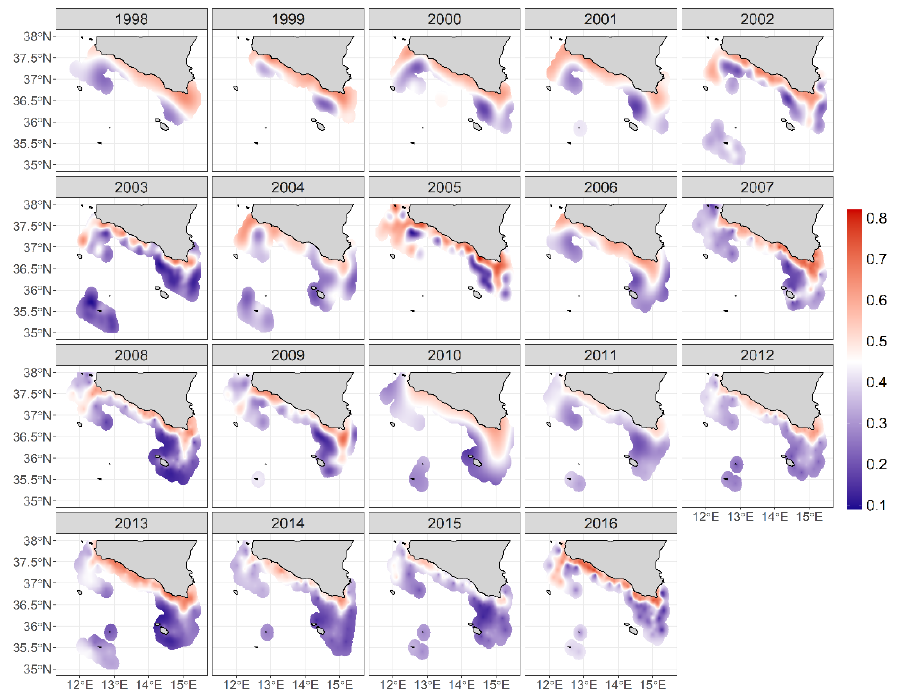
Figure 7. Prediction map of probability of occurrence of anchovy eggs in the Strait of Sicily, based on the ensemble SDMs .